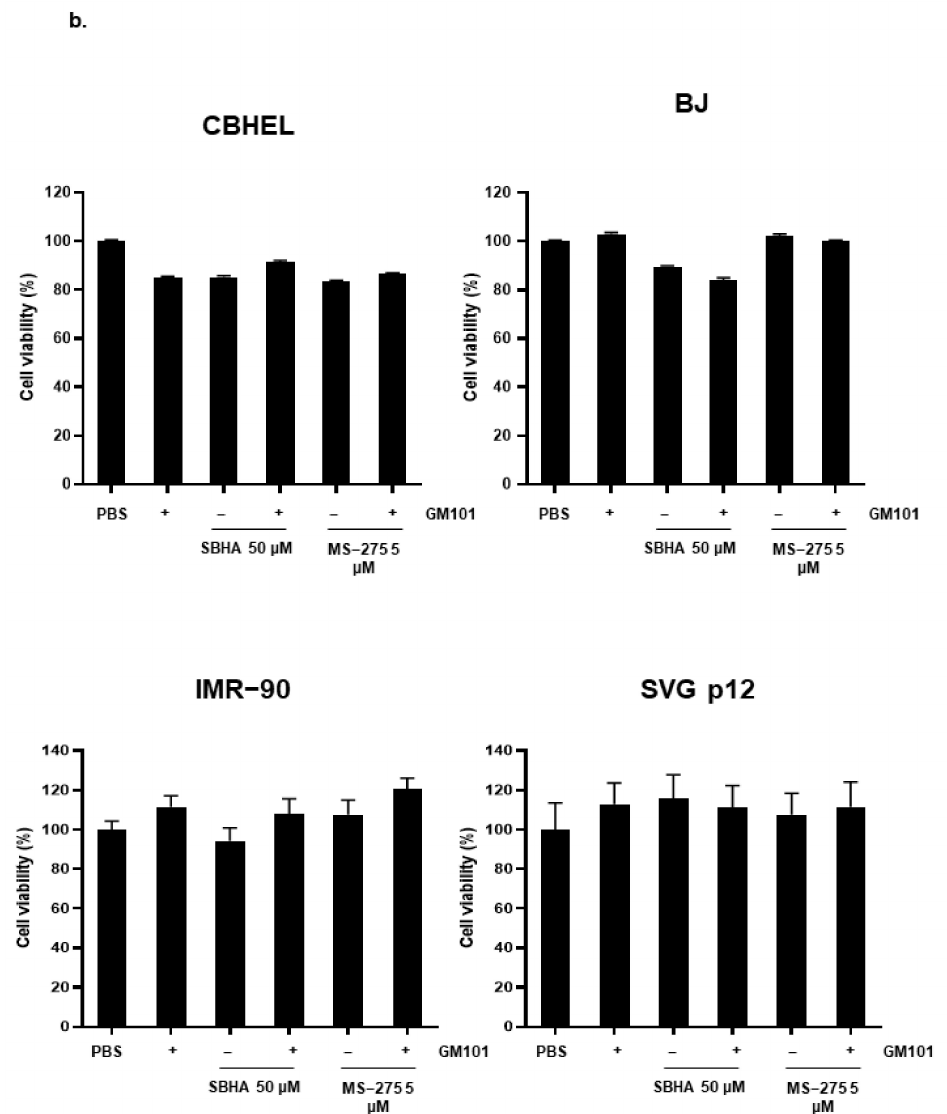
Figure 4. Cancer-specific killing effect of GM101 in combination with HDACi: ( a ) Cancer cells (U343 or A549) and ( b ) normal cells (CBHEL, BJ, IMR-90, or SVG p12) were treated with GM101, GM101+ SBHA, or GM101+MS-275. At 48 h after the GM101 infection, the cell viability was determined by MTT assay. The data are representative of three independent experiments performed in triplicate. Bars represent the mean ± SD. * P < 0.05, ** P < 0.01, *** P <